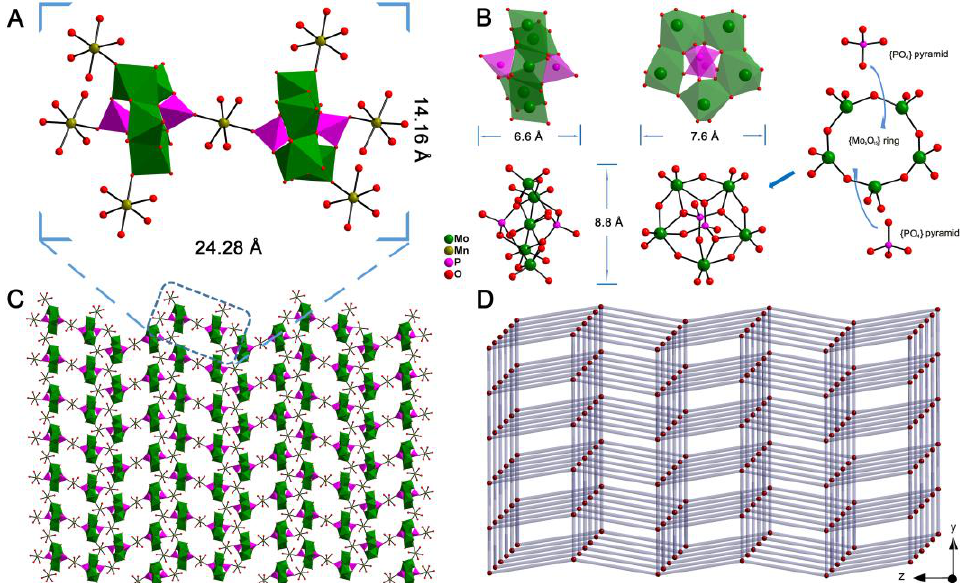
Figure 1. ( A ) Combined polyhedral/ball-and-stick view of the unit of MnPM. ( B ) Polyhedral view and Ball-and-stick representation of one [P 2 Mo 5 O 23 ] 6– cluster. ( C ) 2D network of MnPM. ( D ) Schematic representation of 4-connected uninodal net of MnPM. Table 1. Bond v alence and Σs of Mo, Mn, and P in MnPM .